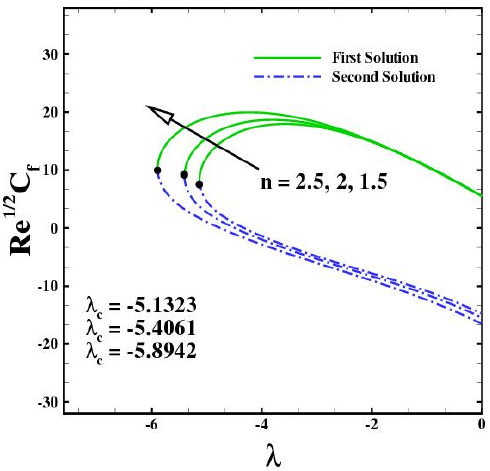
Figure 2. Influence of Re − 1/2 C_f with λ for various values of n and β = We = 0.3, S = 5, M = Ec = 0.5, A = B = 0.1, and Pr = 3.